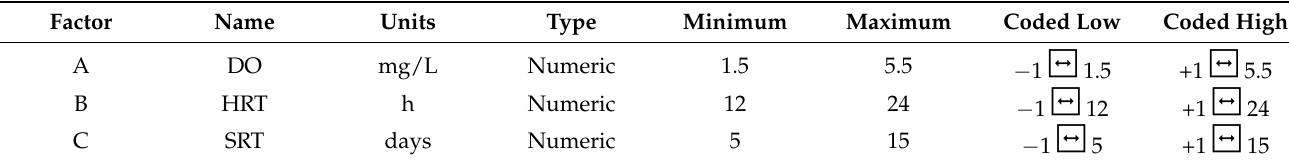
Table 1. Factors and levels for full-factorial design (FFD).